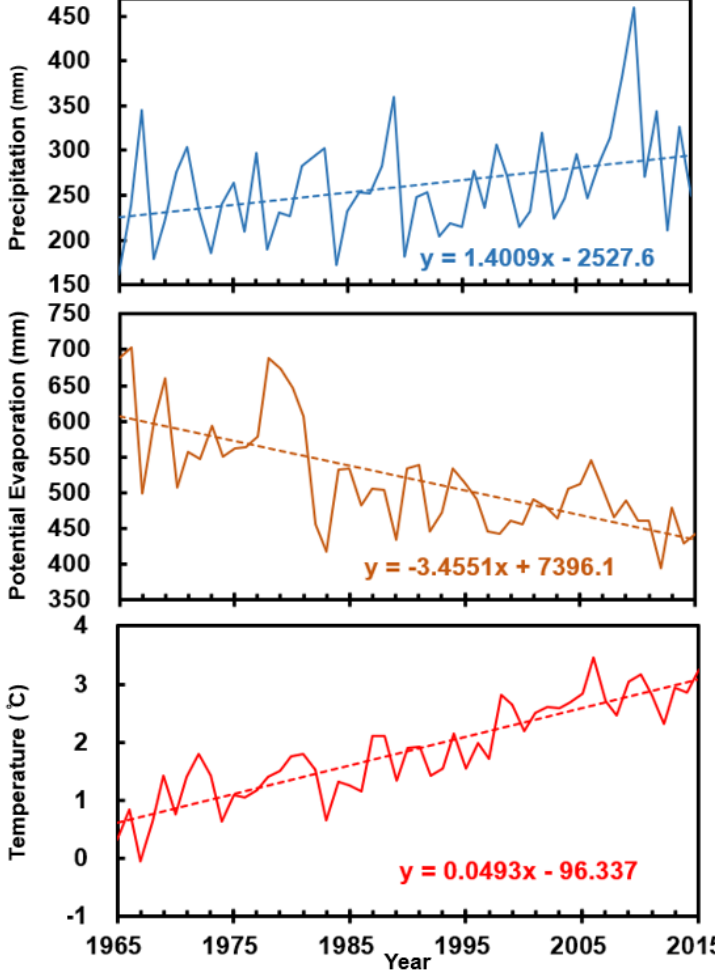
Figure 3. Variations of the annual precipitation, annual potential evaporation and annual mean air temperature in the study catchment, at the basin-scale in average. Streamflow in the Golmud River were observed at two different hydrological stations shown in Figure 4a that operated in different periods. Groundwater levels in the region near the Golmud city